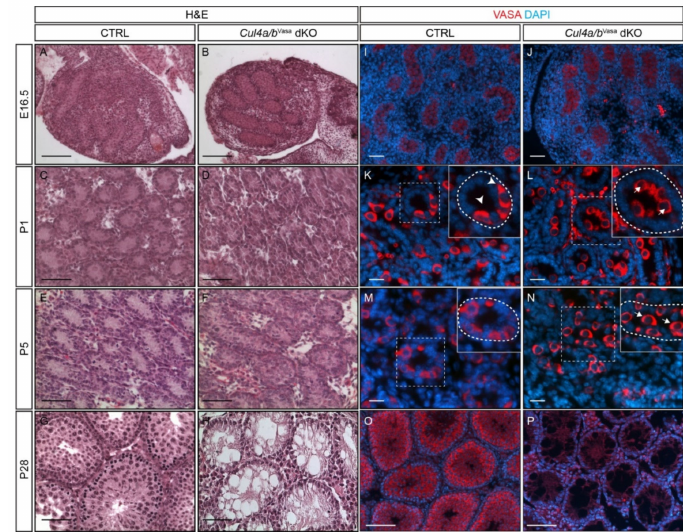
Figure 2. Cul4 genes are essential for spermatogenic cell survival and germ cell homing. ( A – H ) Morphology of testes from E16.5, P1, P5 and P28 CTRL and Cul4a/b Vasa dKO mice by H and E staining. Relative normal morphology was observed in neonatal dKO mutants, however, by P28 the mutant testes are filled with empty tubules. ( I – P ) IF staining of germ cell marker, VASA, in testicular sections of E16.5, P1, P5 and P28 CTRL and Cul4a/b Vasa dKO mice. In neonate mutants, VASA-positive germ cells are present in the dKO seminiferous tubules, but show delay in homing. Insets in ( K – N ) show magnified view of boxed areas; dashed lines outline individual tubules. Note that clusters of germ cells are positioned in the mutant seminiferous tubule lumens (arrows, insets in L , N ), whereas in the CTRLs they have migrated to the basement membranes (arrowheads, insets in K , M ). By P28, VASA-positive germ cells are no longer detectable in dKO testes. Scale bars: 100 µ m in ( A – D ), ( O , P ); 50 µ m in ( E – N